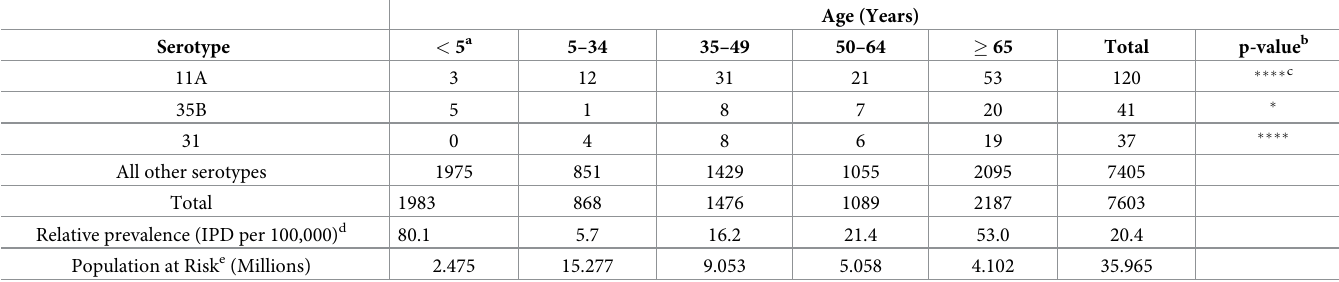
Table 2. Frequencies of invasive pneumococcal disease by